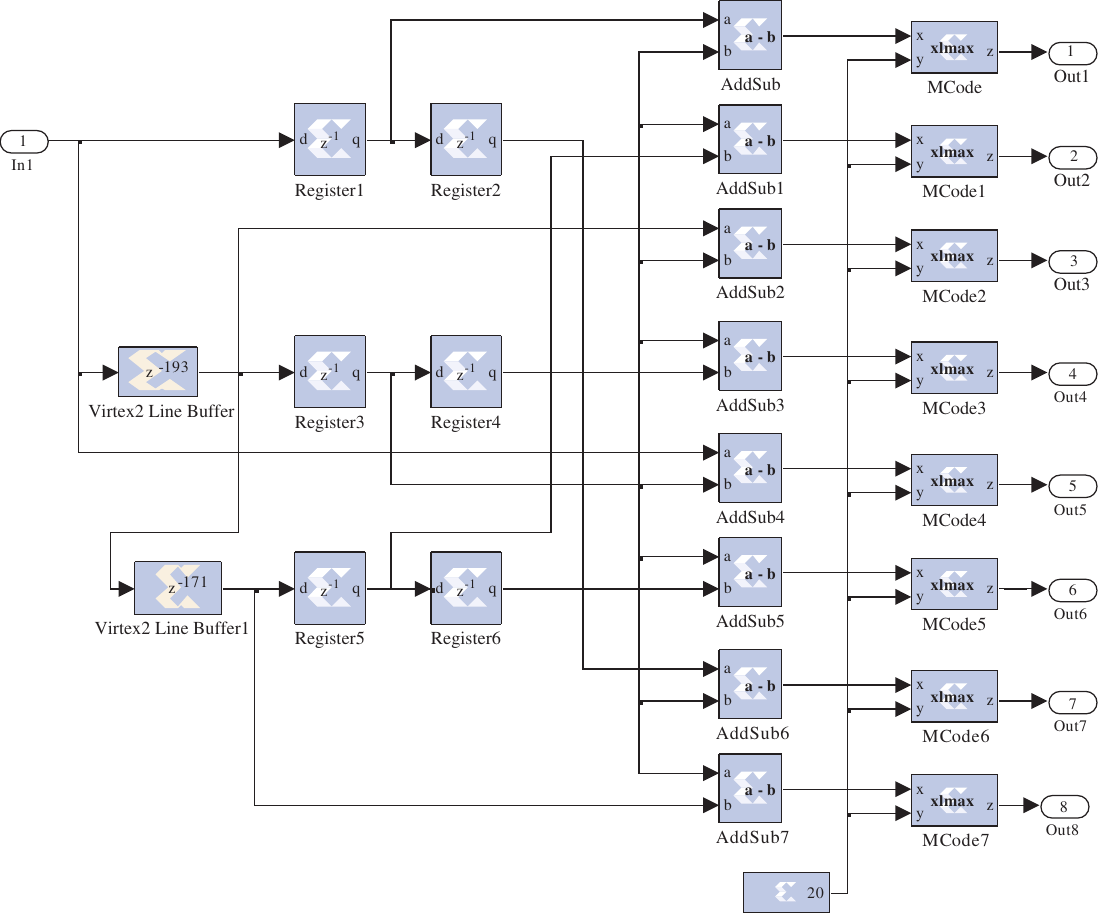
Figure 11. Differentiating and Thresholding